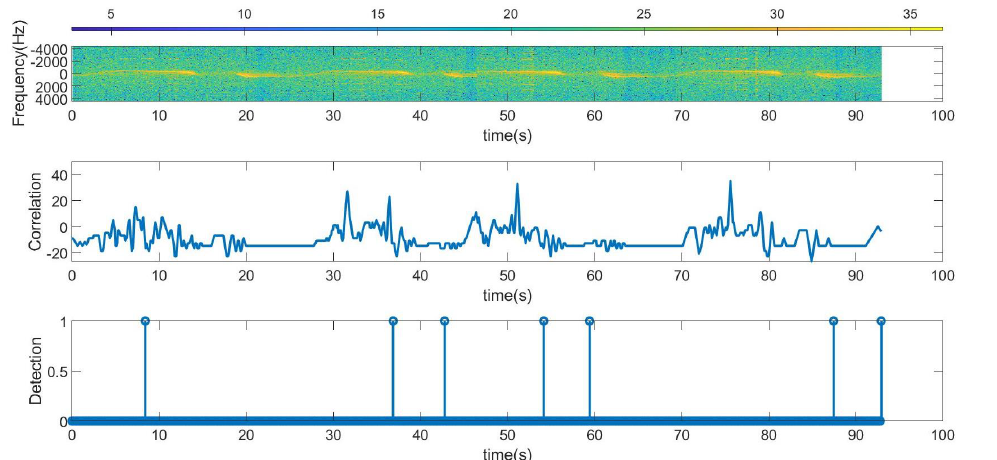
Figure 20. Measurement for a moving scooter sending Barker codes with length 13. From top to bottom: raw spectrogram before the CFAR processor is applied, the output of the correlator and tag detection.